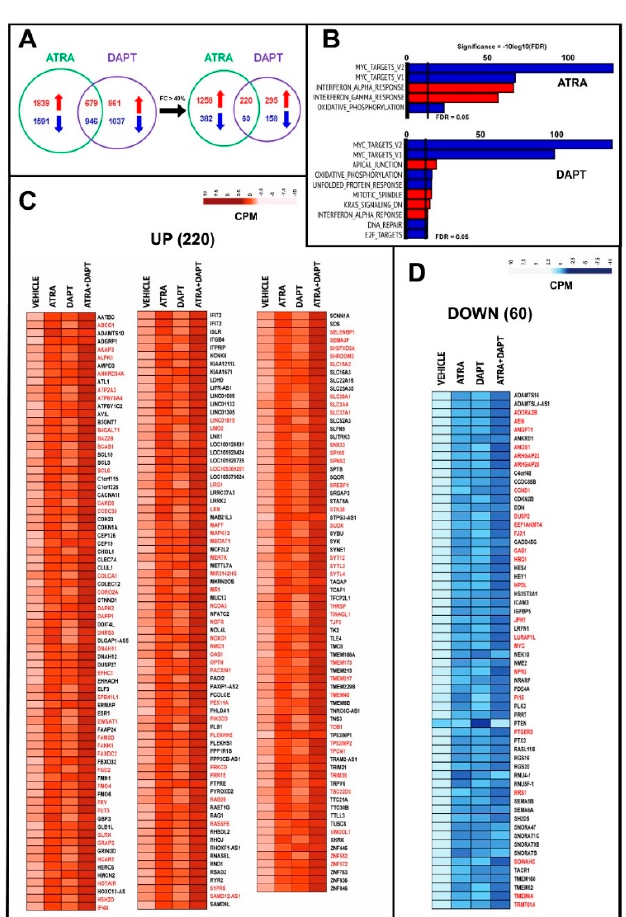
Figure 6. RNA-seq analysis of HCC-1599 cells exposed to ATRA, DAPT and ATRA + DAPT. Three paired biological replicates of HCC-1599 cells were grown in DMEMF12 medium containing 5% charcolated FBS (Fetal Bovine Serum, Gibco) for 24 h. Cells were treated with vehicle (DMSO), ATRA (1 µ M), DAPT (1 µ M) or the combination of ATRA and DAPT (ATRA + DAPT) for another 8 h. RNA was extracted and subjected to RNA-seq analysis. ( A ) The Venn diagram on the left illustrates the number of genes significantly up-regulated (red) and down-regulated (blue) by ATRA and DAPT. The Venn diagram on the right shows the number of genes significantly up-regulated (red) and down-regulated (blue) by ATRA and DAPT following application of the indicated threshold value (see also Table S1). ( B ) The panels show the top Hallmark pathways significantly enriched for genes up-regulated (red) or down-regulated (blue) by ATRA and DAPT in HCC-1599 cells. The vertical black lines indicate the FDR (False Discovery Rate, corrected p -value < 0.05) thresholds considered. ( C , D ) The heat-maps show the expression profiles of the 220 genes commonly and significantly up-regulated ( C ) and the 60 genes commonly and significantly down-regulated ( D ) by both ATRA and DAPT following application of the threshold value indicated in panel ( A ). The e ff ects of the ATRA + DAPT combination are also shown. The up- and down-regulation of the genes marked in red (up-regulated = 92; down-regulated = 23) is significantly enhanced by ATRA + DAPT relative to ATRA and DAPT alone (at least p < 0.05 following two-way ANOVA).